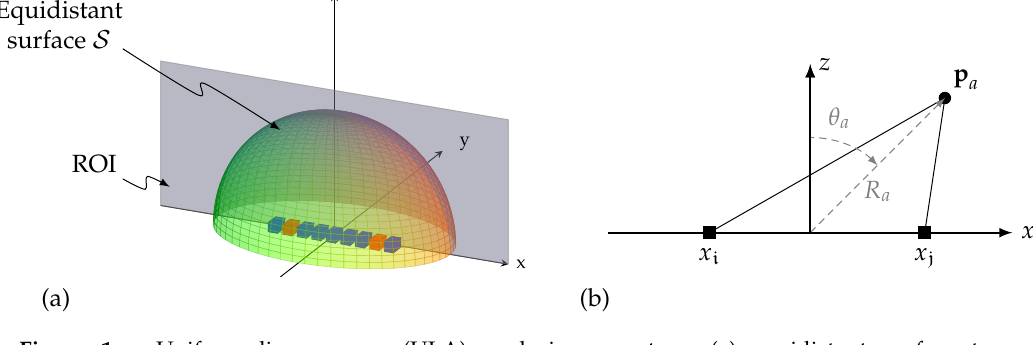
Figure 1. Uniform linear array (ULA) analysis geometry: ( a ) equidistant surface to a transmitter–receiver pair, ( b ) y = 0